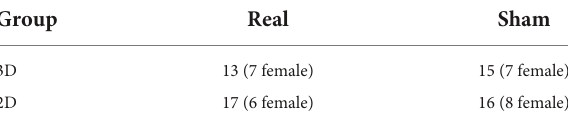
TABLE 1 Description of the cohort distribution in all four groups.